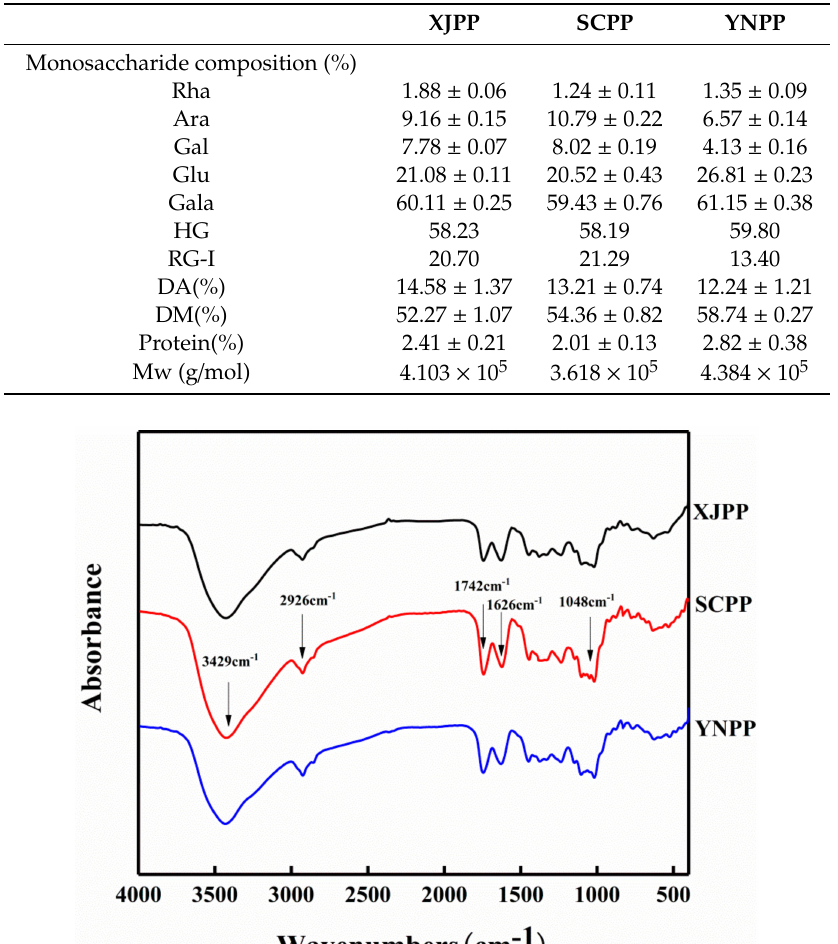
Table 1. Composition and molecular weight of pectin monosaccharides from pomegranate peel from di ff erent areas.